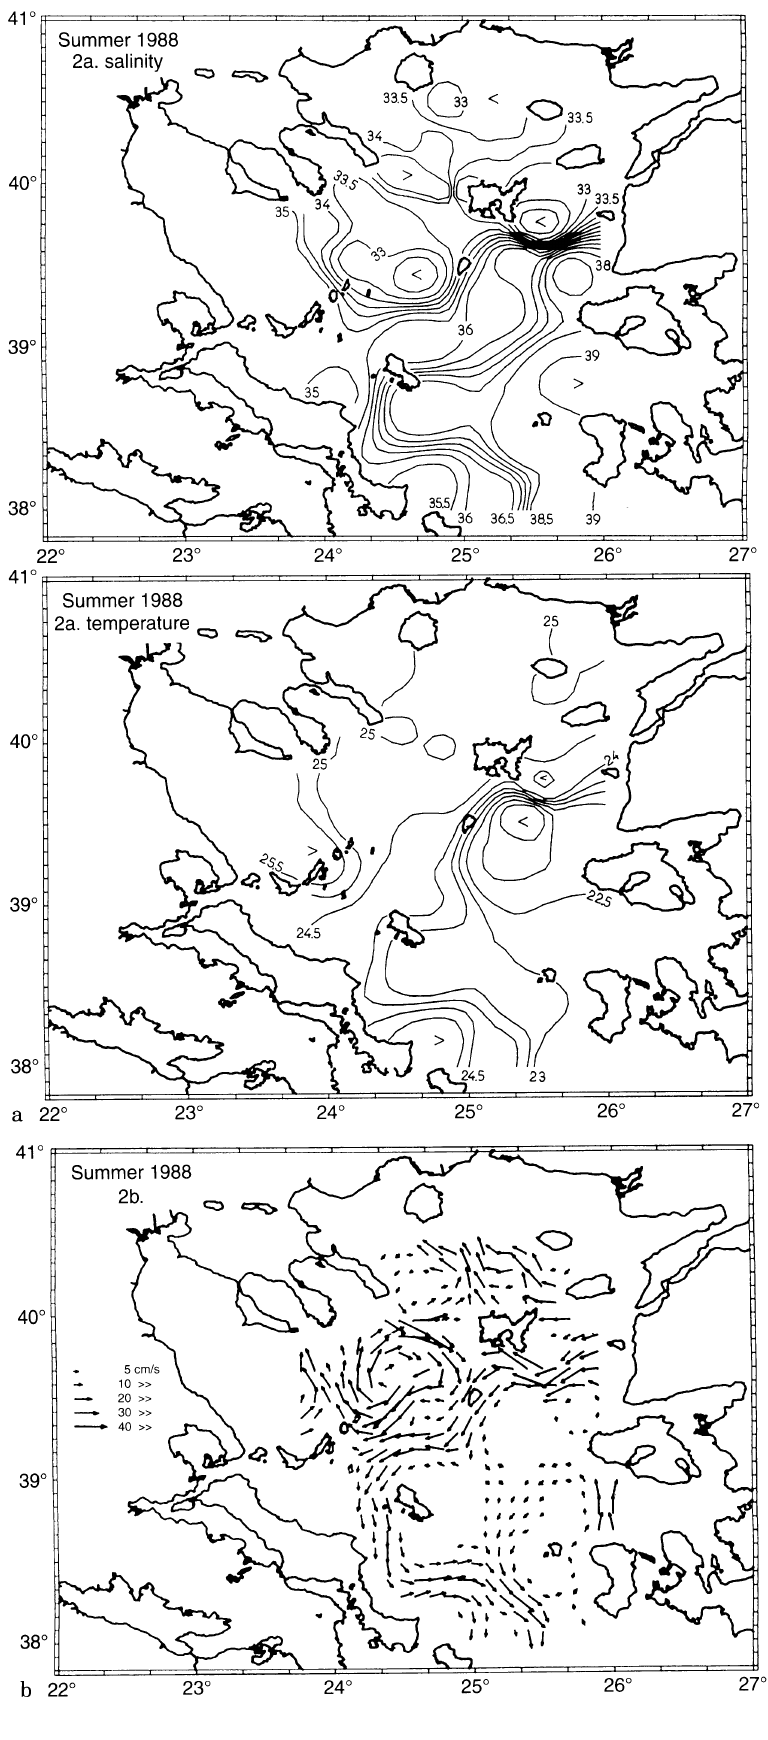
Fig. 2. a Horizontal distribution of surface salinity, used as tracer for the BSW in the Aegean Sea, indicating the patch of the BSW in the discharge region of the Hellespont, summer period (after Zodiatis and Balopoulos, 1993). b Surface geostrophic currents in the North Aegean, summer period, revealing the BSW flow, the anticyclonic eddy in the NW Aegean and the weak northward flow in the SE part of the sea (after